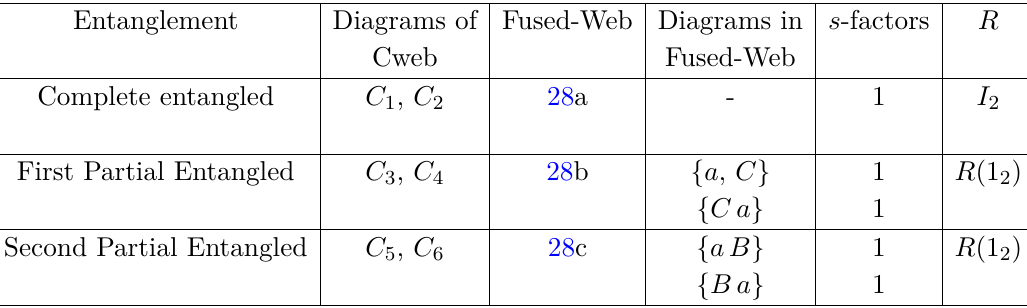
Figure 28. Fused-Webs for Cweb W (2 , 1)